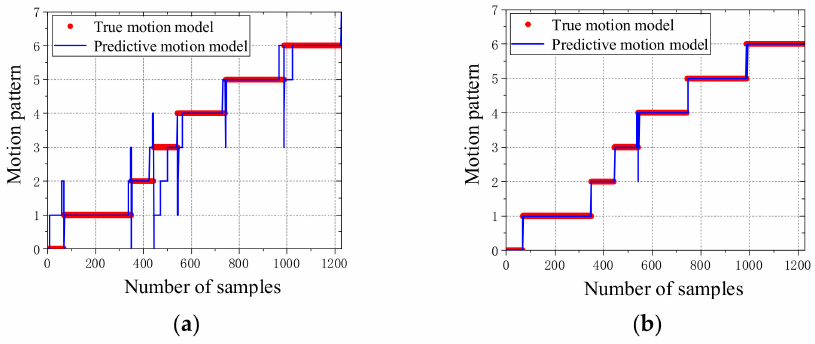
Figure 9. E ff ects of trend term on classification accuracy. ( a ) Recognition results of unremoved trend term. ( b ) Recognition results of removed trend